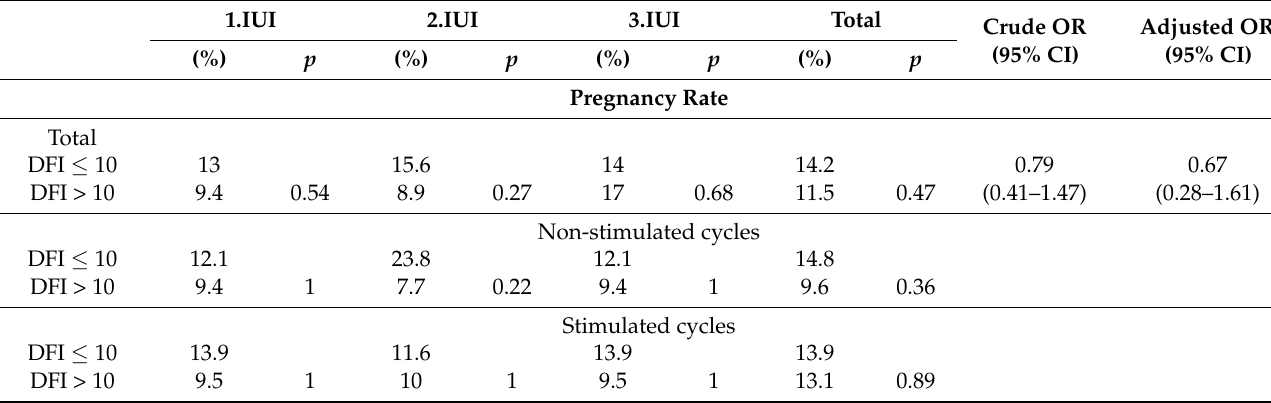
Table 3. Pregnancy rates and live birth rate for the first, second and third IUI is presented. All females received an ovulation inducer before insemination. Approximately half of the cycles were otherwise non-stimulated. The other half was stimulated with chlomiphen and/or